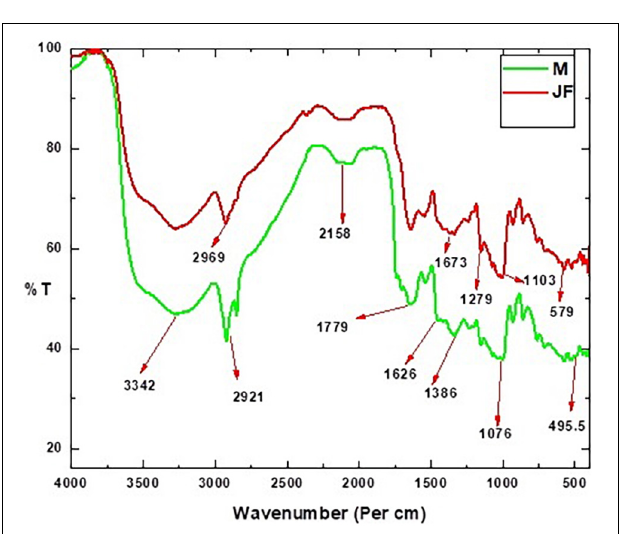
FIGURE 2 | FTIR spectra of bio-sorbent material of Mango (MF) and Jack fruit (JF) kernel biomass.